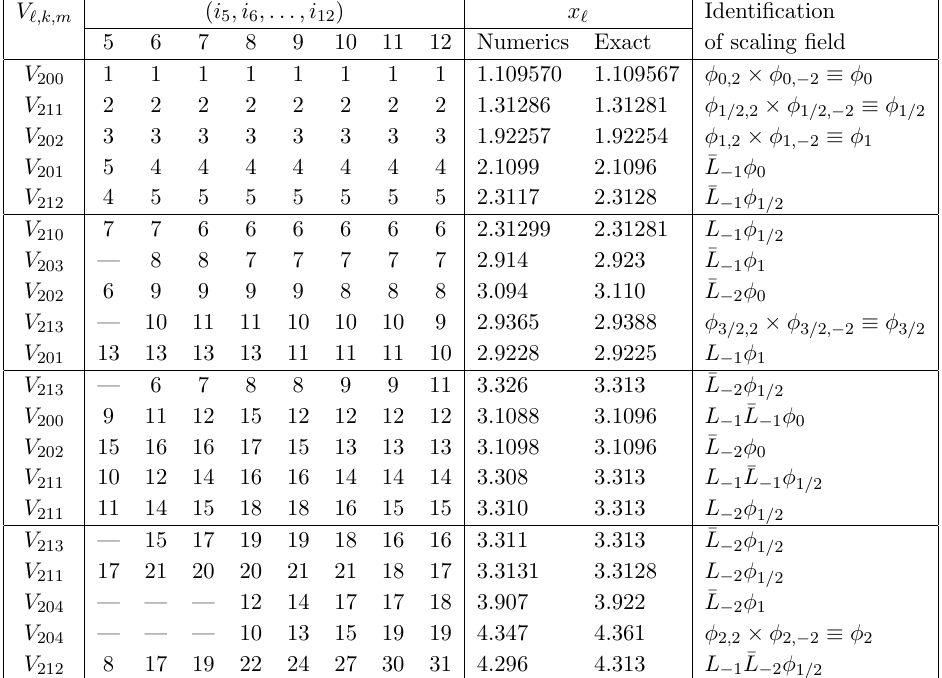
Table 3 . Conformal spectrum in the sector V 2 , for Q = 1